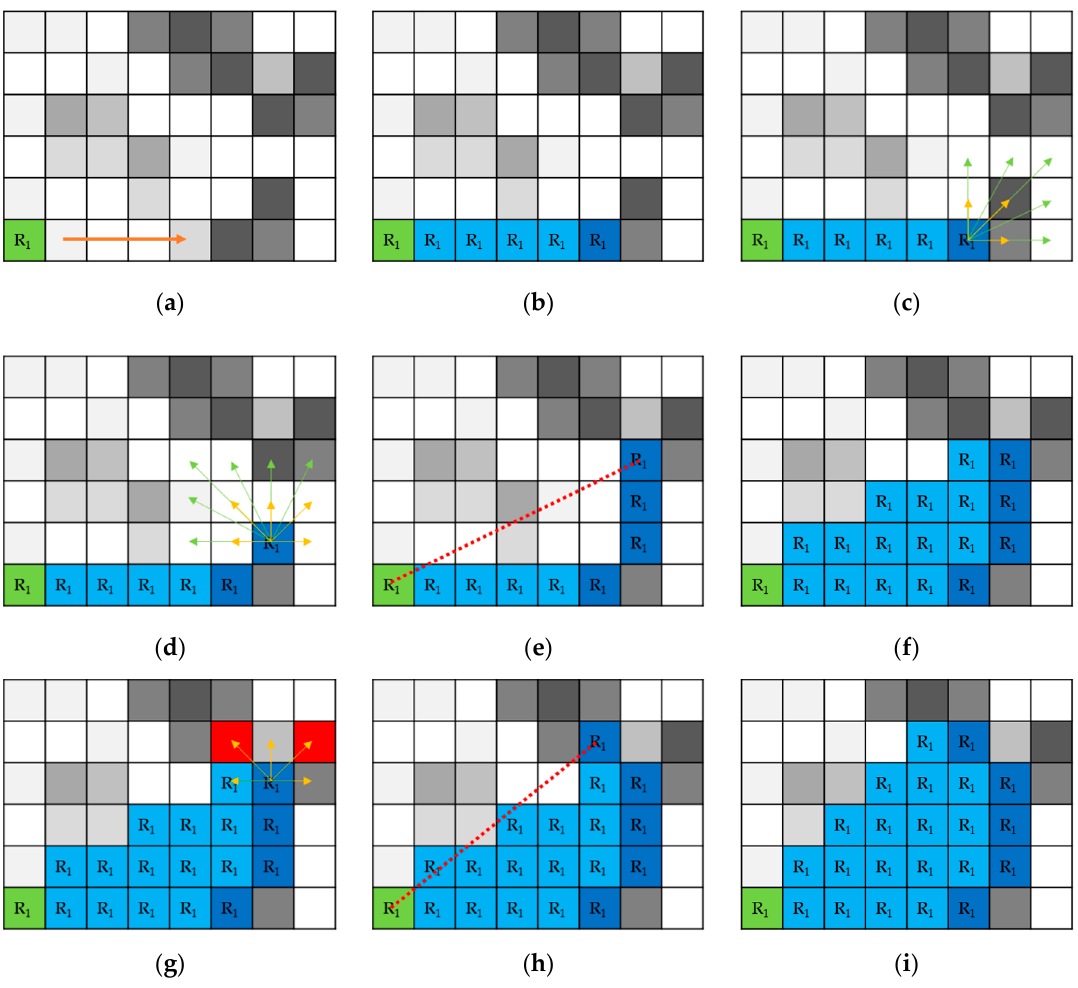
Figure 9. Detailed steps of the proposed algorithm. Region growing ( a , b ), edge tracking ( c , d ), region updating ( e – i ), selection of proper edge direction ( g , h ).